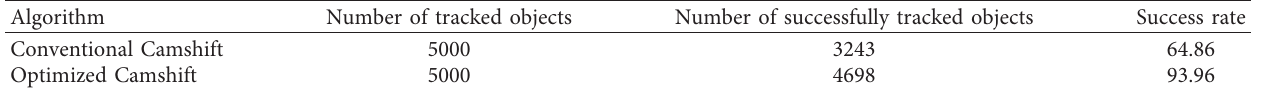
Table 1: The tracking success rate of the two algorithms under the object motion state.